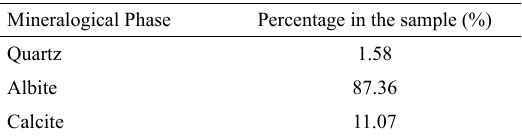
Figure 2. X-ray diffractogram of cement.